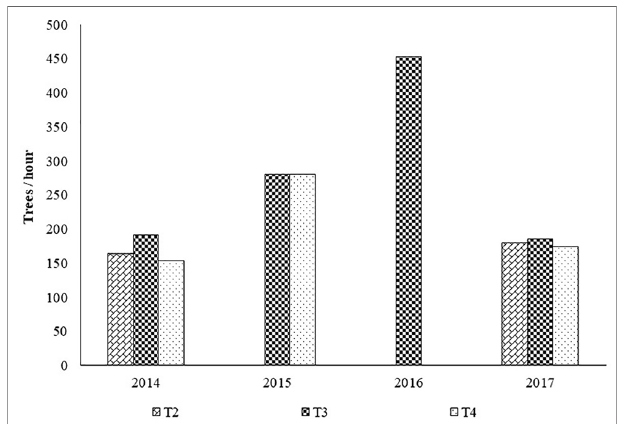
FIGURE 6 | Pruning costs per treatment. Legend: T1, treatment 1; T2, treatment 2; T3, treatment 3; T4,